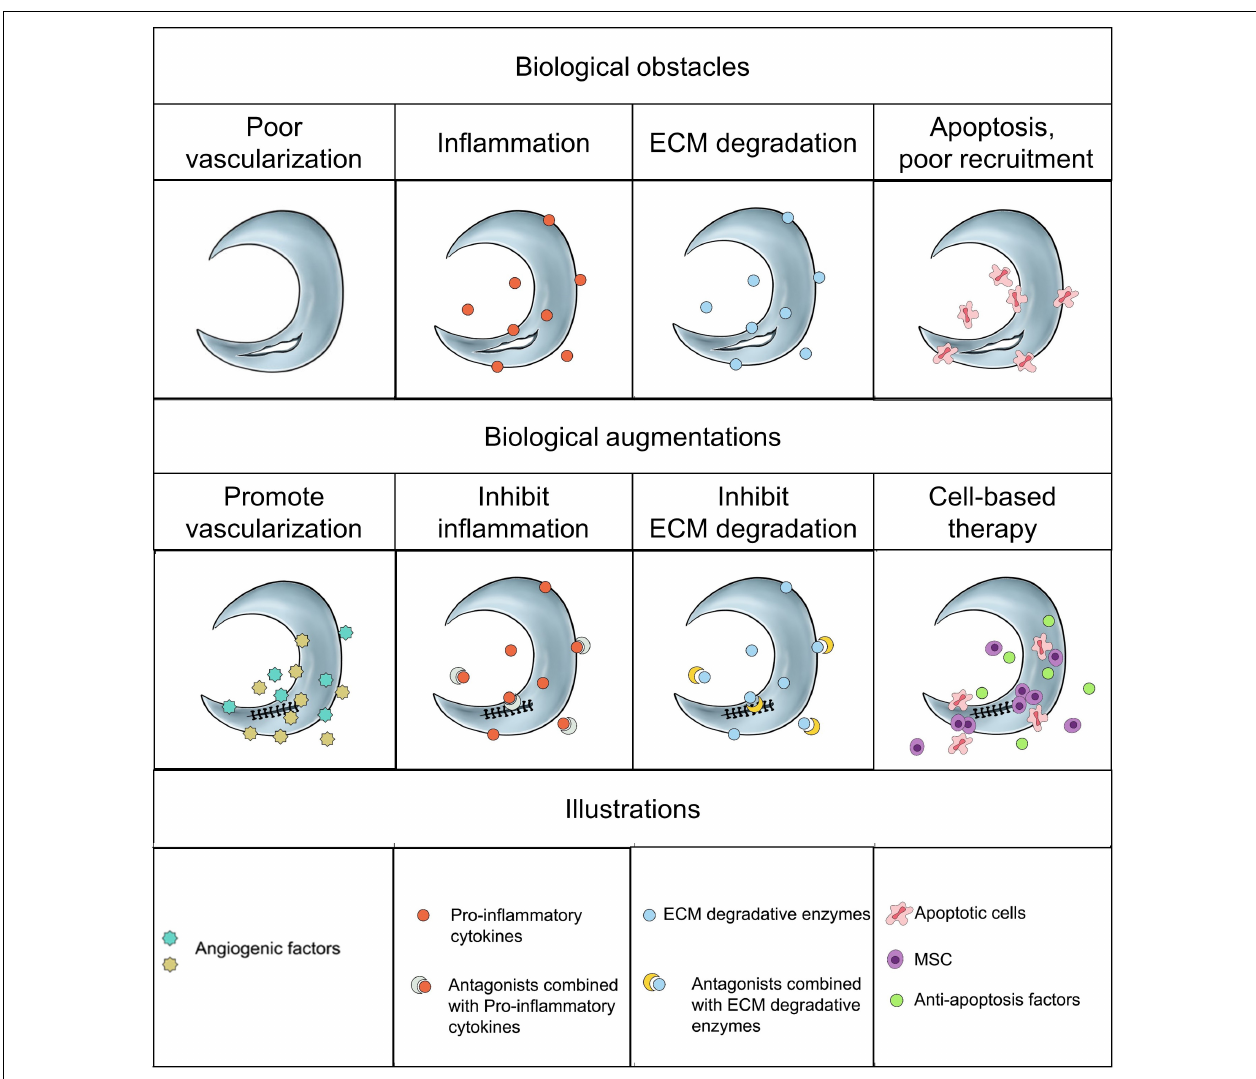
FIGURE 3 | The schematics of the current biological obstacles and biological augmentations for meniscal avascular zone repair.